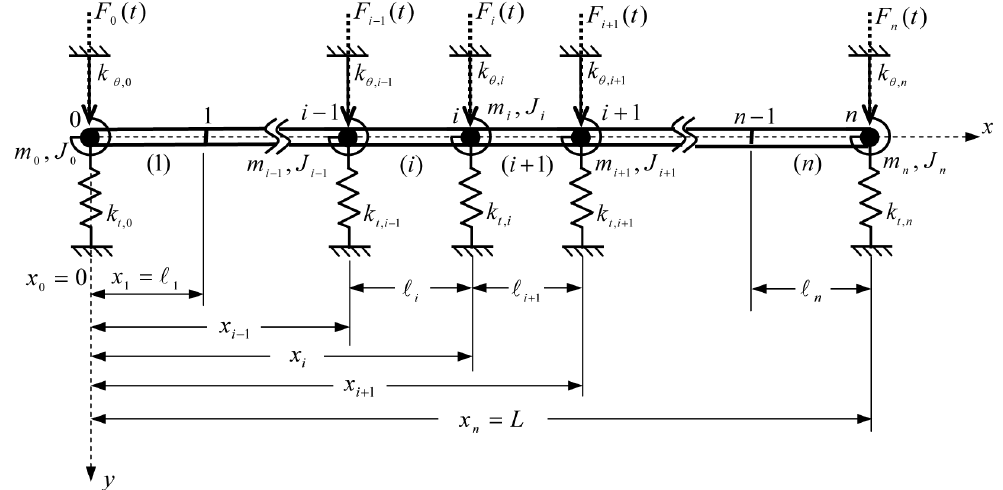
Fig. 1. A uniform free-free beam composed of n uniform beam segments (denoted by (1), (2), ... , ( i -1), ( i ), ( i + 1), ... , ( n )) separated by n − 1 nodes (denoted by 1, 2, ... , i − 1, i , i + 1, ... , n − 1) and carrying a lumped mass ˆ m i (with rotary inertia J i ), a translational spring k ti , a rotational spring k θi and a concentrated force F i ( t ) at each node i , i = 0,1,2, ... , n .